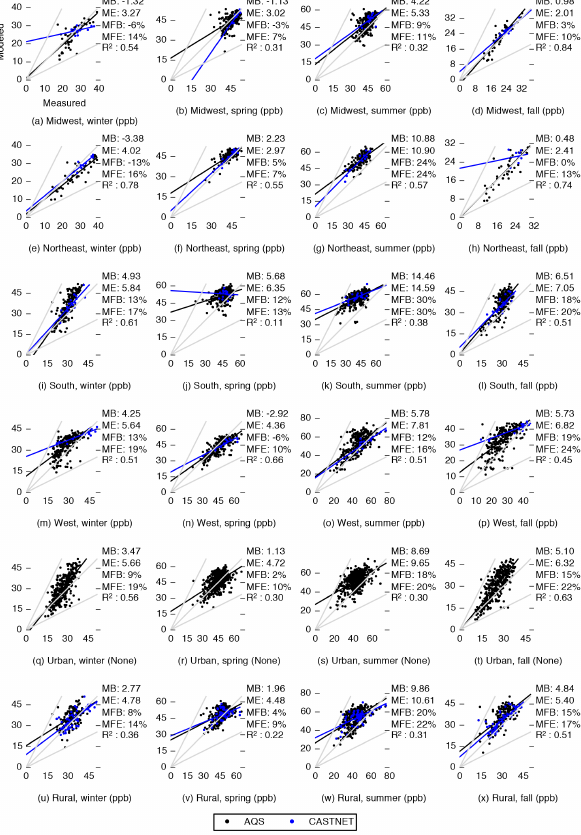
Figure 6. Comparison of measured and modeled annual average of daytime O 3 concentrations disaggregated by season and region. Region boundaries are shown in Fig.